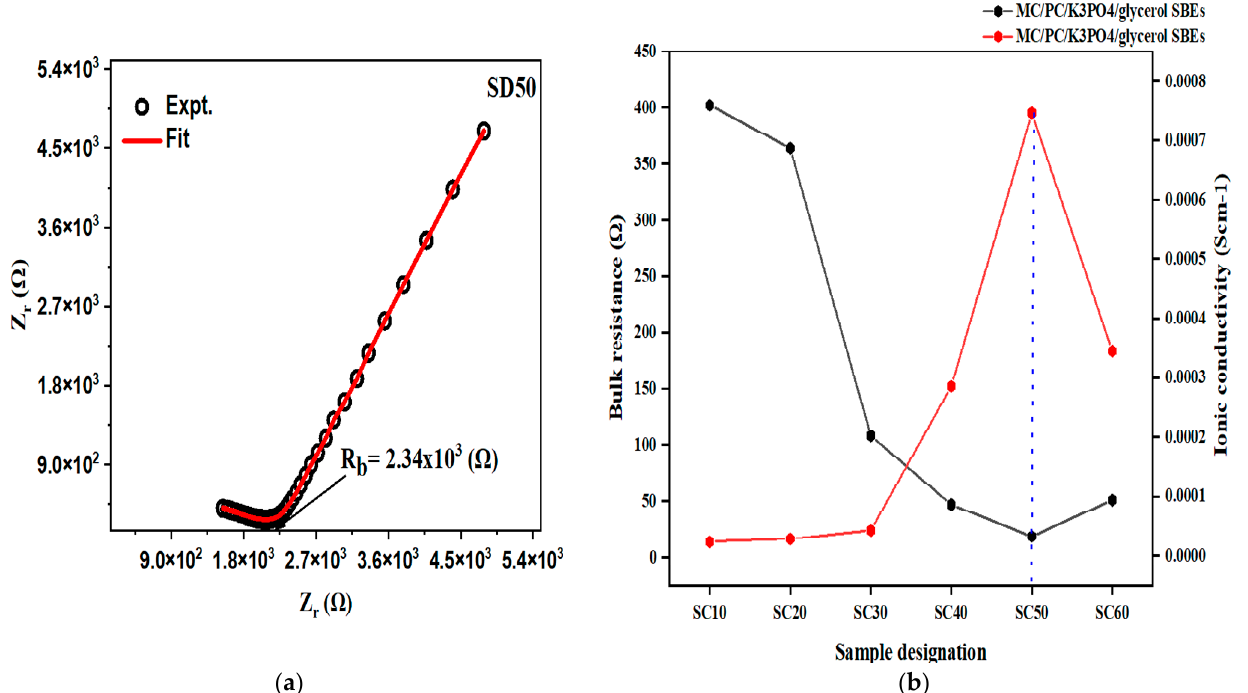
Figure 4. ( a ) Ionic conductivity of SD50; ( b ) ionic conductivity trend of MC/PC/K 3 PO 4 /glycerol SBEs.